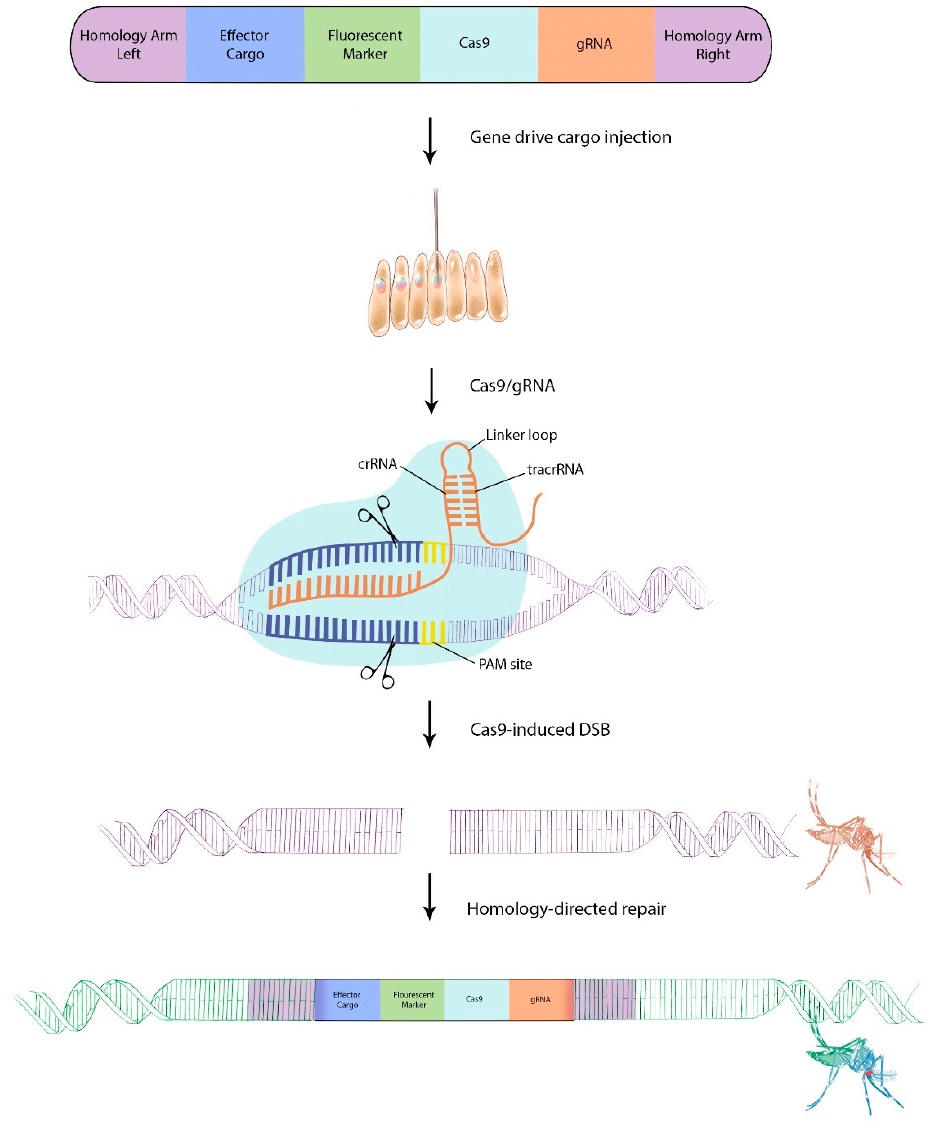
Figure 3. Generalized flow chart for the establishment of a one-component CRISPR / Cas9-based gene drive system in Ae. aegypti . Antiviral e ff ector cargo, when expressed alongside the necessary components of the CRISPR / Cas9 system, can be driven into mosquito populations. Such a gene drive construct would contain (1) flanking homology arms that are complementary to the CRISPR / Cas9 target site in the mosquito genome, (2) the antiviral e ff ector under control of a tissue-specific promoter, (3) a discernable marker (such as a fluorescent protein under control of a photoreceptor-specific promoter), (4) the Cas9 enzyme under control of a germline-specific promoter, and (5) a gRNA under control of an RNA polymerase III (U6) promoter. The construct is injected into pre-blastoderm embryos for site-specific germline integration. Once expressed, the gRNA forms a complex with the Cas9 enzyme and guides it to complementary sequences upstream of a PAM site. The Cas9 enzyme then induces a DSB 3–5 bp upstream of the PAM site. If the cell uses HDR to repair the DSB, the homologous sequence in the donor plasmid will be used as template to repair the DSB. The G1 o ff spring then represents transgenic mosquitoes, which are capable of gene driving by targeting the wild-type allele with CRISPR / Cas9 and repairing the cleavage though HDR, thereby inserting the entire gene drive system including the antiviral e ff ector cargo.